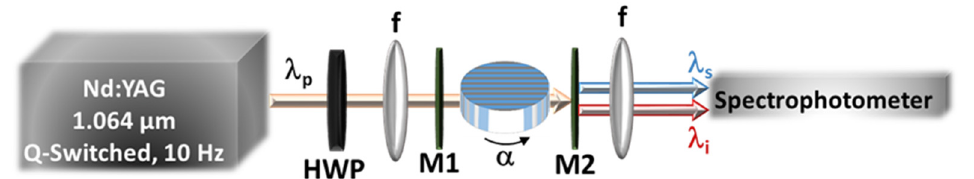
Figure 13. Experimental scheme of a cylindrical OPO. HWP is a half-wave plate. M1 and M2 are the two plane mirrors of the cavity. ( λ p , λ s , λ i ) are the pump, signal and idler wavelengths, respectively, verifying 1/ λ p = 1/ λ s + 1/ λ i .